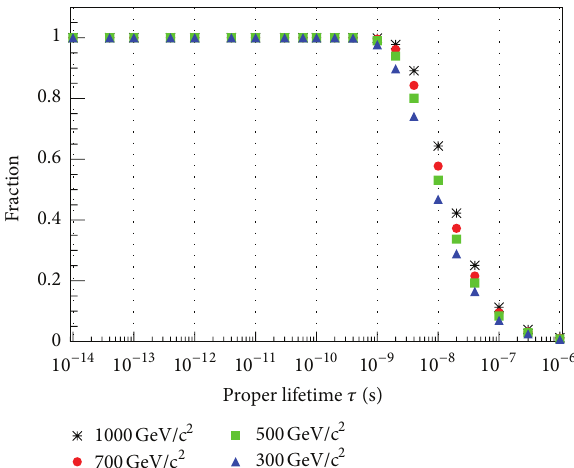
Figure 8: Fraction of rejected decays of heavy quarks within the volume of the CMS tracking detector as a function of the proper lifetime 𝜏 .